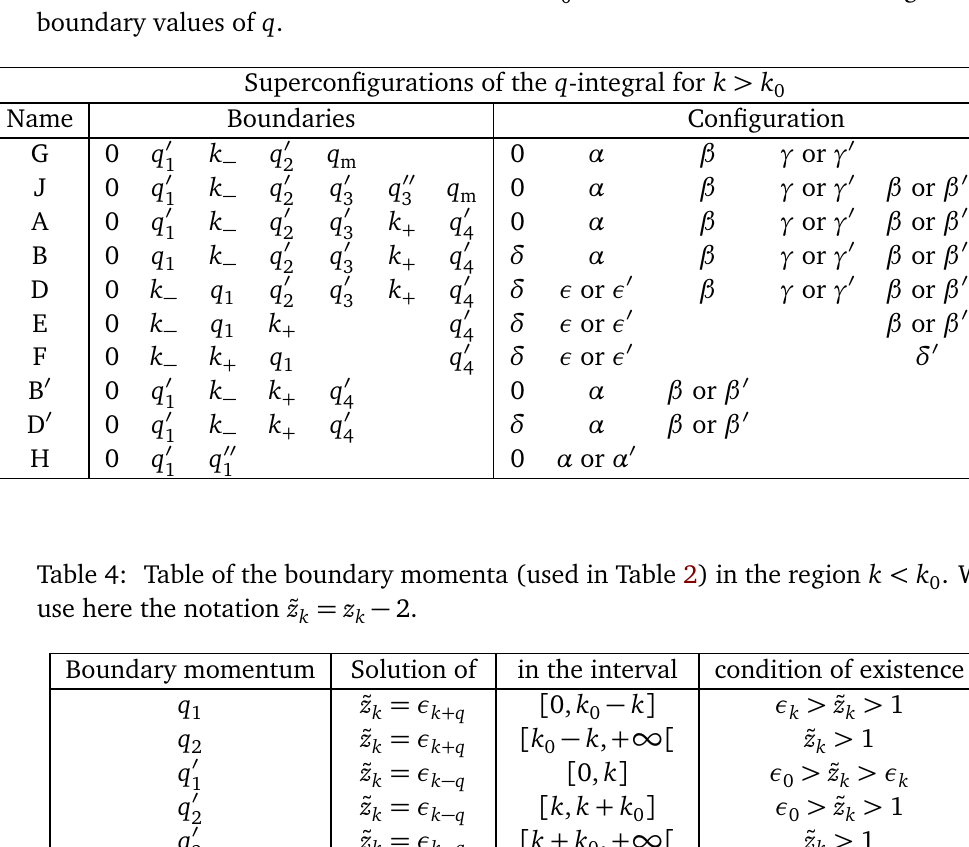
. See Table 5 for the meaning of the 0